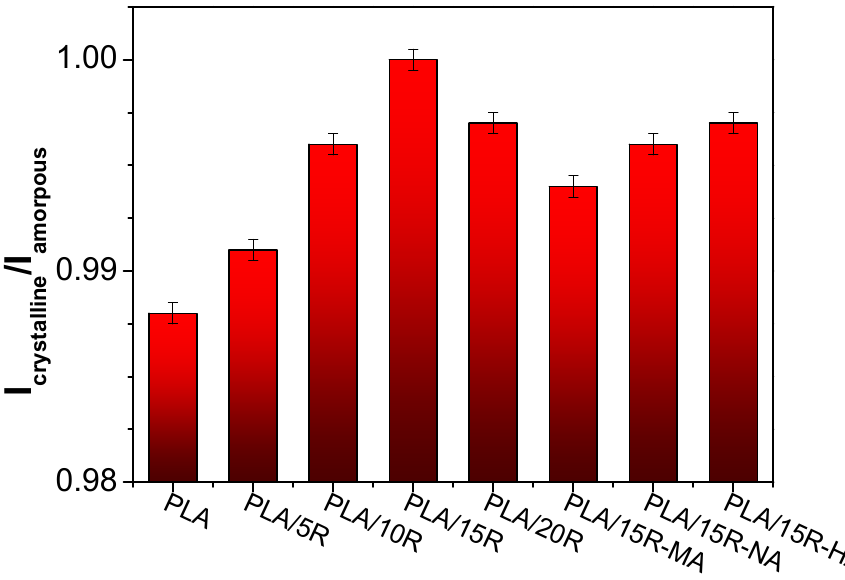
Figure 3. I crystalline /I amorpous ratio derived from FTIR data. Although the variations in the I crystalline /I amorphous ratio calculated from the FTIR spectra are small, they provide insight into the crystallinity indices calculated more precisely from DSC thermograms. A slight increase of the I crystalline /I amorphous ratio from 0.988 in PLA up to 1.00 in PLA/15R is evident in the case of PLA/unmodified R blends. This indicates a modification in the structure of the systems containing plasticizers due to the increase in chain mobility. Similar findings have been reported in the literature [45–47]. The crystallinity indices of PLA/anhydrides modified R slightly decreased compared to PLA/R, from 1.00 in PLA/15R to 0.994 in PLA/15R-MA (Figure 3). The variation in the modification corresponds with the composition of modified R. It appears that the plasticization efficiency was higher for the sample containing HA- and NA- modified R, which recorded the highest crystallinity index values among the modified